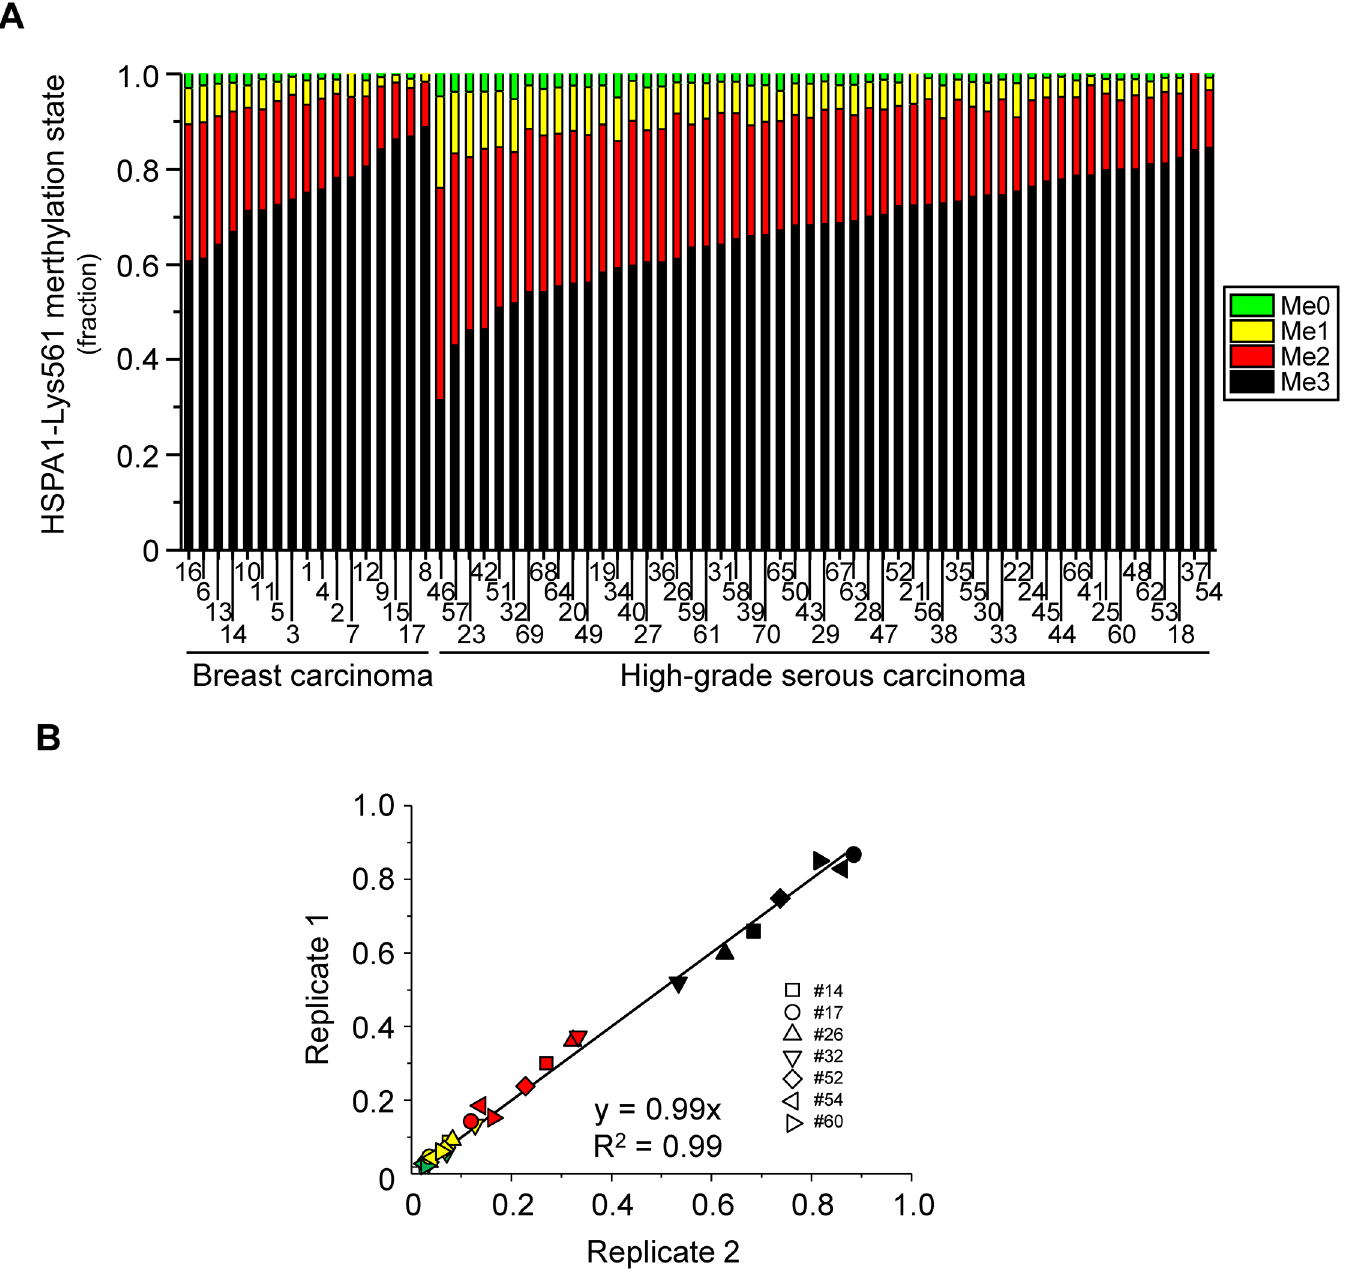
Fig 2. Assessment of HSPA1-Lys561 methylation status in HGSC and breast carcinoma effusions. (A) Quantitative mass spectrometry analysis of HSPA1-Lys561 methylation. Samples were analyzed as exemplified in Fig 1. The relative abundance of the various methylation states (me0, me1, me2 and me3) of Lys561 in HSPA1 in 17 breast carcinoma (cases # 1 – 17) and 53 HGSC (cases # 18 – 70) samples is shown. The data are grouped by cancer type and sorted by increasing relative abundance of me3. (B) Reproducibility of the analysis. A second analysis of 2 randomly chosen breast cancer samples and 5 randomly chosen HGSC samples was performed, and the results were plotted versus the original data set. Data points for the various lysine methylation states are color-coded as in (A) and each tumor sample is represented by a unique geometrical